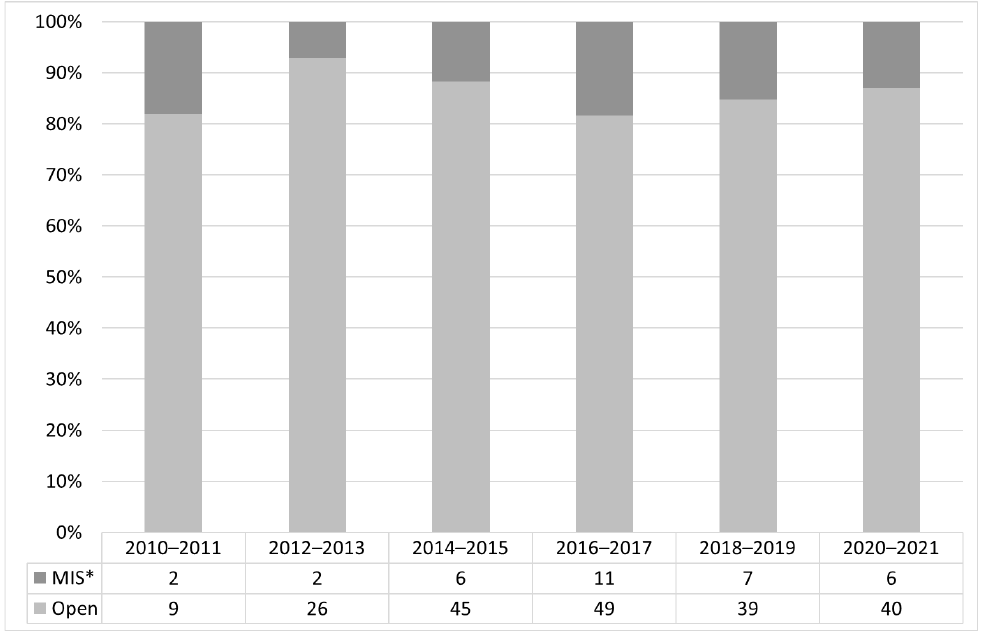
Figure 1. Percentage of minimally invasive vs. open primary anastomosis and tracheoesophageal fistula-repair in the historic control group in patients with esophageal atresia/tracheoesophageal fistula (Gross Type B/C/D, n = 242) of the patient registry (courtesy of the German esophageal atresia patient support group KEKS e.V.).*: minimally invasive surgery.